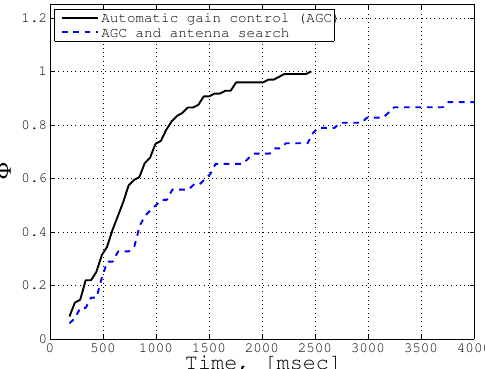
Figure 17. Cumulative distribution function of sync time during ISL sessions